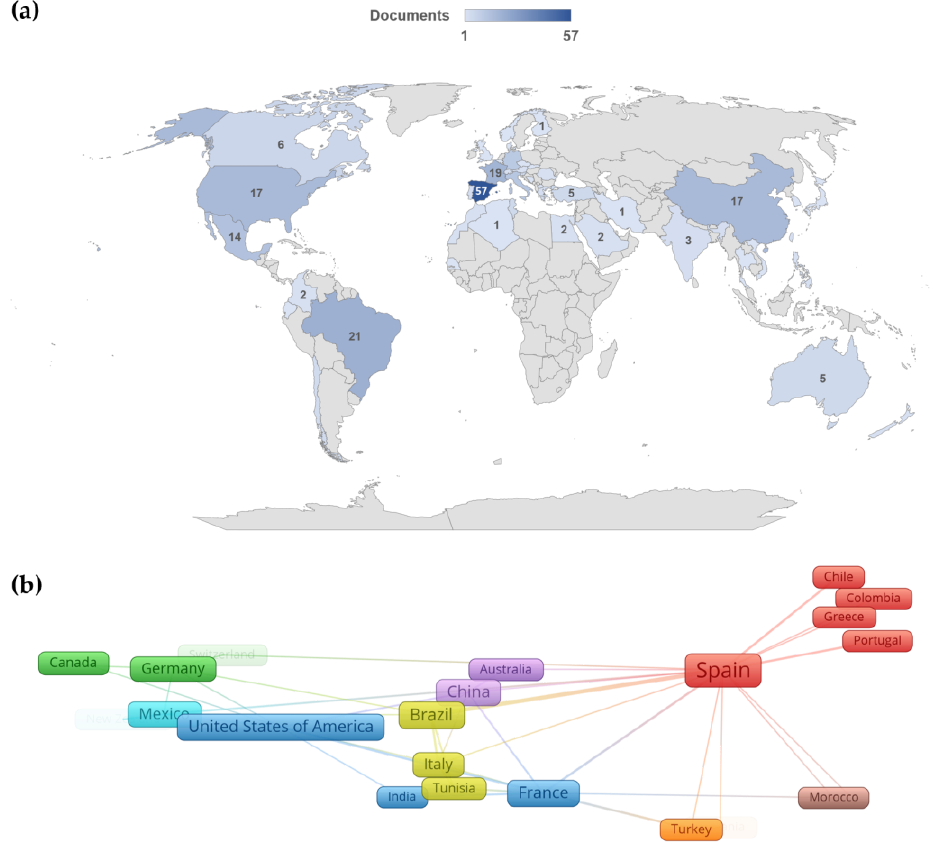
Figure 7. ( a ) Number of publications per country on EAOPs using diamond technology for water treatment; ( b ) countries’ co-authorship network (minimum of two occurrences) representation on the application of EAOPs using diamond technology for water treatment, based on the VOSviewer bibliometric mapping software [55]. All results were based on the SLR article selection performed in the Scopus database. Considered period: 2002–2022. Source: the authors.